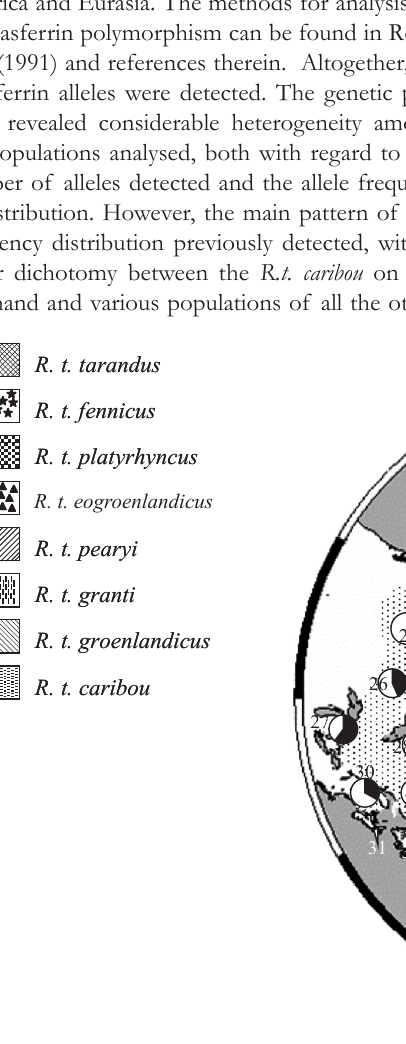
Fig. 2. Frequency distribution of three pooled transferrin alleles (Tf A-3 , Tf A-2 and Tf A-1 ) given as section of pies. Num- bers refer to the sampled population provided in Table 1. The indicated subspecies distribution is as for Fig.